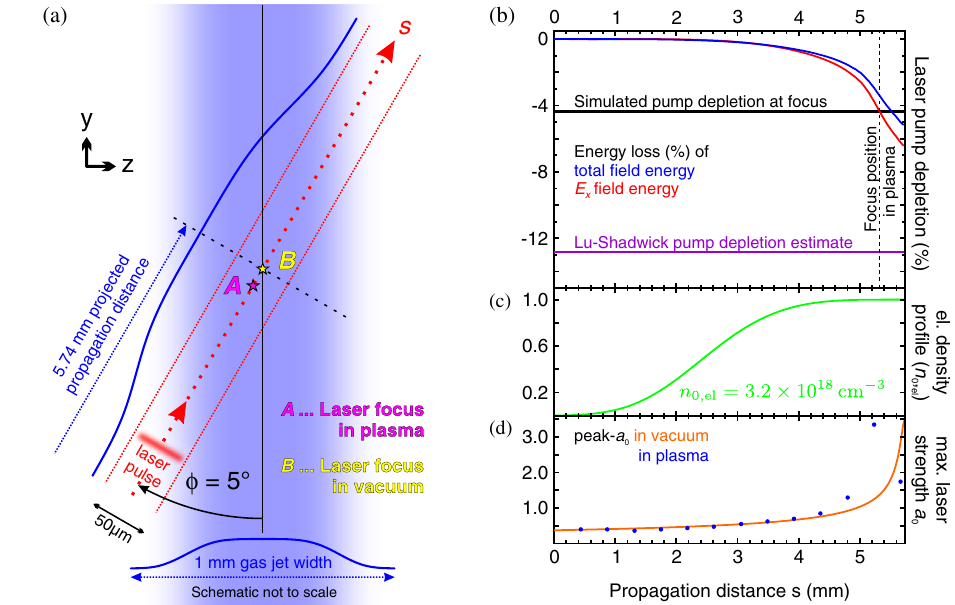
FIG. 8. (a) A schematic of the laser propagation setup. An 800-nm, 10-fs, linearly polarized laser with 50 - μ m pulse-front width is ¼ 1 . 2 - μ m focal line height and a maximum field strength of a ¼ 3 . 5 along the y axis, which coincides with cylindrically focused to w 0 0 ;x the center of a 1-mm-width slit-nozzle gas jet target. The laser pulse is obliquely incident at an angle of 5°. The 3D-PIC simulation models the pulse evolution along 5.74-mm propagation distance from vacuum until the center of the gas jet. Marker A refers to the laser focus in plasma (spatial offset is due to self-focusing), while B denotes the original focus invacuum. For better visibility, the schematic is not drawn to scale. (b) The relative loss of the total (blue line) and E (red line) field energy in the simulation volume with respect to the propagation x distance. The respective energy losses within the focus at s ¼ 5 . 32 mm are 3.4% and 4.4%, which is less than one-third of the analytical estimate of 12.8% derived from LWFA depletion according to Refs. [15,84]. (c) The assumed relative electron density profile projected ð z Þ ¼ 3 . 2 × 10 18 cm − 3 · exp ð − z 4 = ( 3 . 138 × 10 − 4 m Þ 4 ) has an along the laser direction of propagation. The super-Gaussian profile n el ( s · sin ð ϕ Þ ) . (d) The laser approximate vacuum-to-vacuum width of 1 mm. However, the projected density profile seen by the laser is n el pulse peak electric field in the dimensionless laser strength unit a 0 along the laser direction of propagation for in-vacuum propagation (solid) compared to the propagation in plasma (blue markers), where self-focusing dynamics leads to an earlier focus.